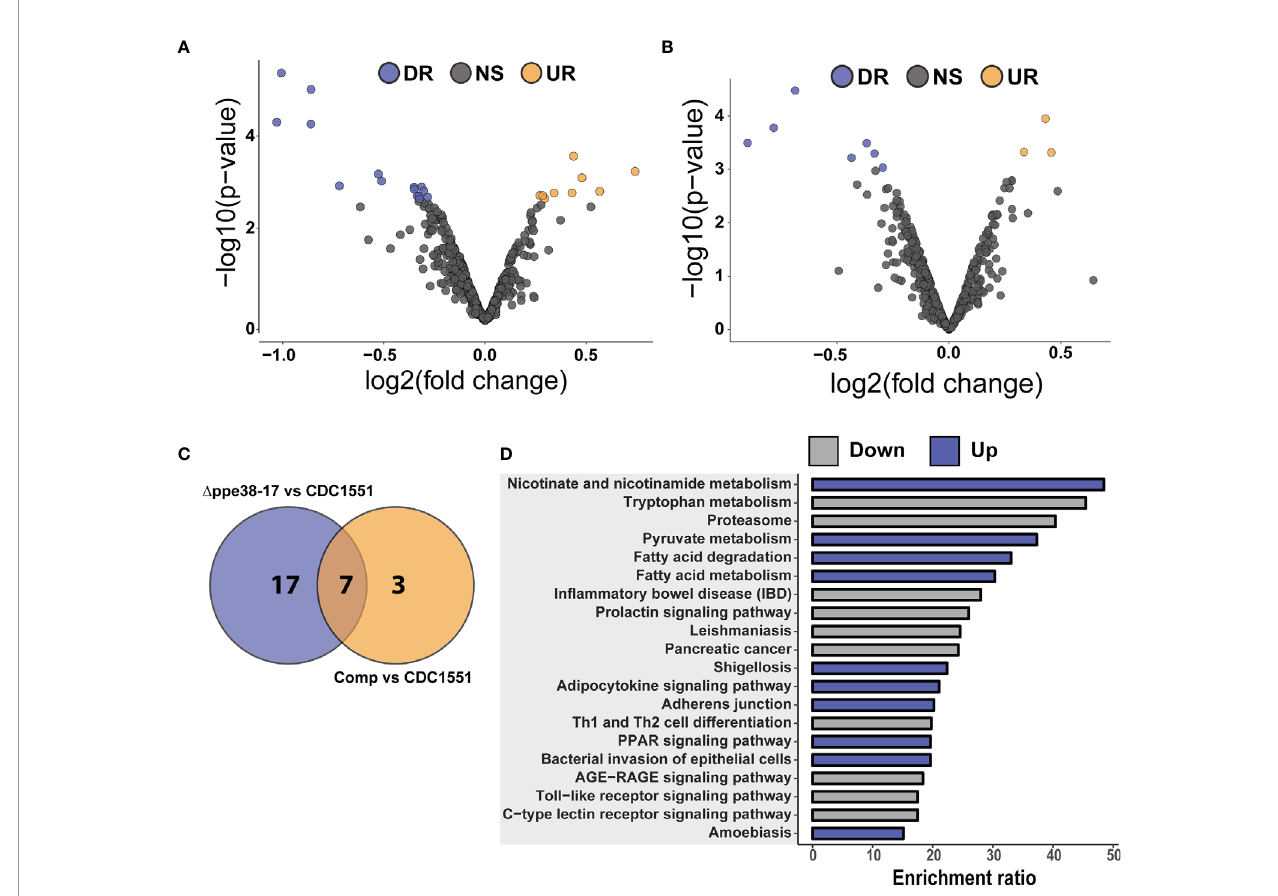
FIGURE 4 | Differential regulation of individual protein half-lives point towards changes in the in fl ammatory response. Volcano plot depicting altered protein half-lives between (A) M. tuberculosis CDC1551- and D ppe38-71- infected macrophages or (B) M. tuberculosis CDC1551- and complement-infected macrophages. Signi fi cantly altered protein half-lives are highlighted based on q-value set at 0.05. Downregulated proteins are denoted as DR (purple), upregulated as UR (orange) and non-signi fi cant as NS (grey) in the volcano plots. (C) Venn diagram depicting the number of macrophage protein half-lives present either uniquely or commonly between the M. tuberculosis CDC1551 infected and D ppe38-71 infected macrophage and between M. tuberculosis CDC1551 infected and complement-infected macrophage comparisons. Data is representative of two biological replicates. (D) Over-representation analysis of the proteins with differentially regulated half-lives against KEGG pathways, where up is indicative of rapid turnover and down indicative of slower turnover. Over-representation was calculated using the WebGestalt API using default